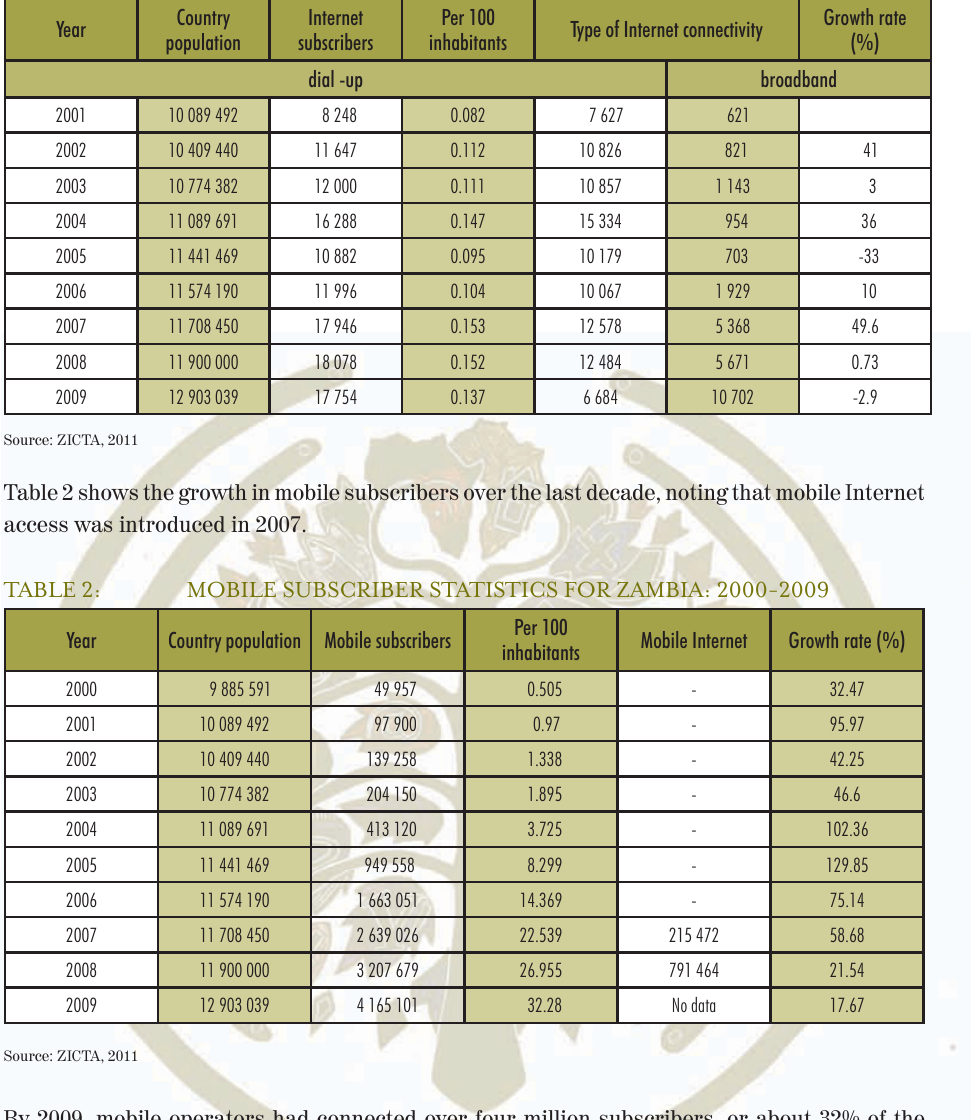
MOBILE SUBSCRIBER STATISTICS FOR ZAMBIA: